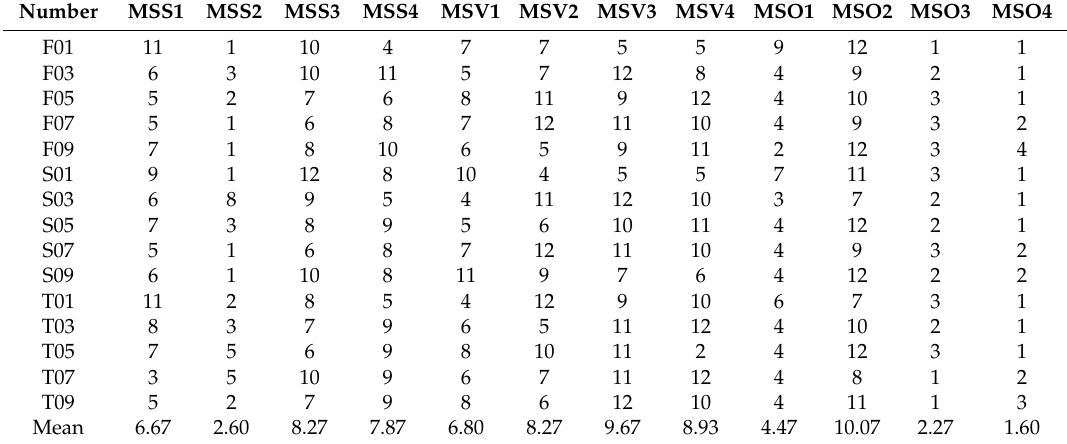
Table 6. Ranks of twelve discrete MS algorithms based on the best values.